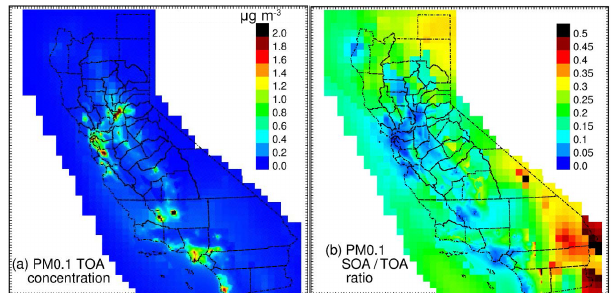
Figure 4. Predicted 9-year average (a) PM 0 . 1 total OA (TOA) con- centration and (b) PM 0 . 1 SOA / TOA ratio in